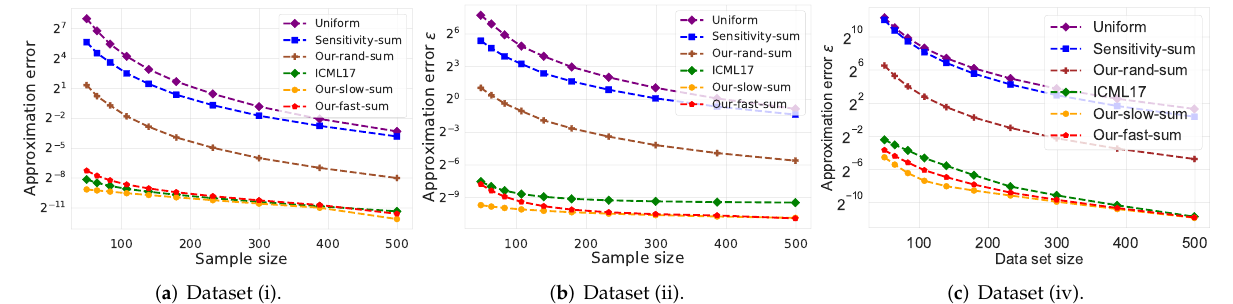
Figure 2. Experimental results for vector summarization. The x axis is the size of the subset (coreset), while the y axis is the approximation error (cid:107) µ − µ s (cid:107) 2 . The difference between the two graphs is the chosen dataset.